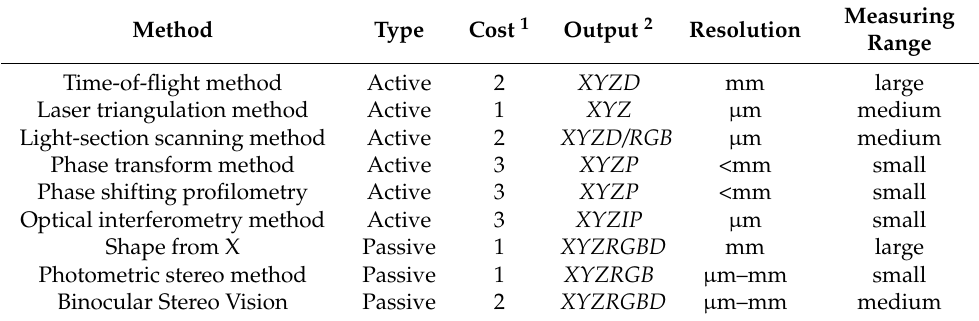
Table 1. The detailed comparison results of various classical